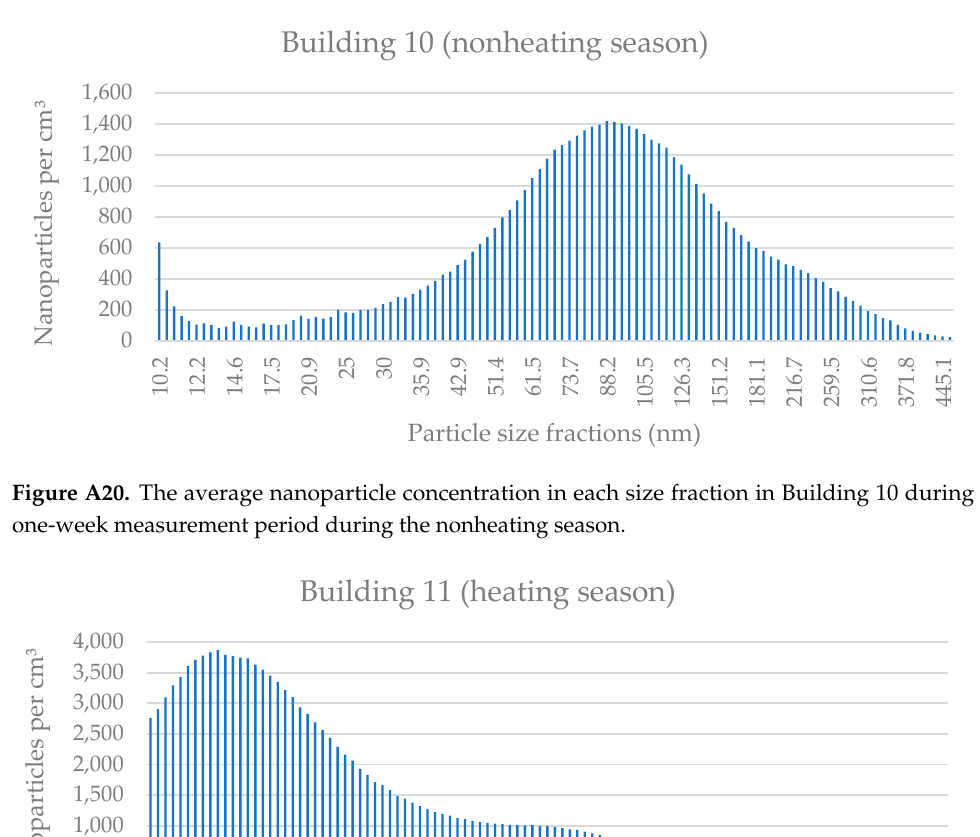
Figure A19. The average nanoparticle concentration in each size fraction in Building 10 during a one-week measurement period during the heating season.